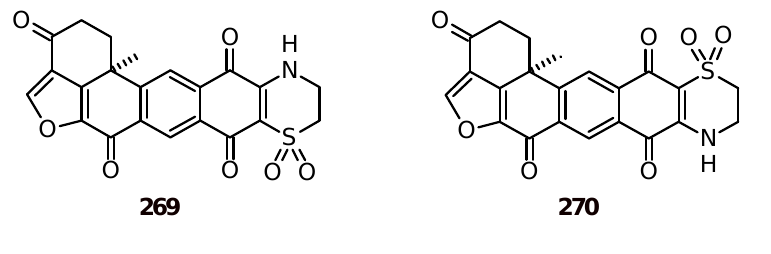
Figure 33. Structures of halenaquinone derivatives and analogues 269 - 271